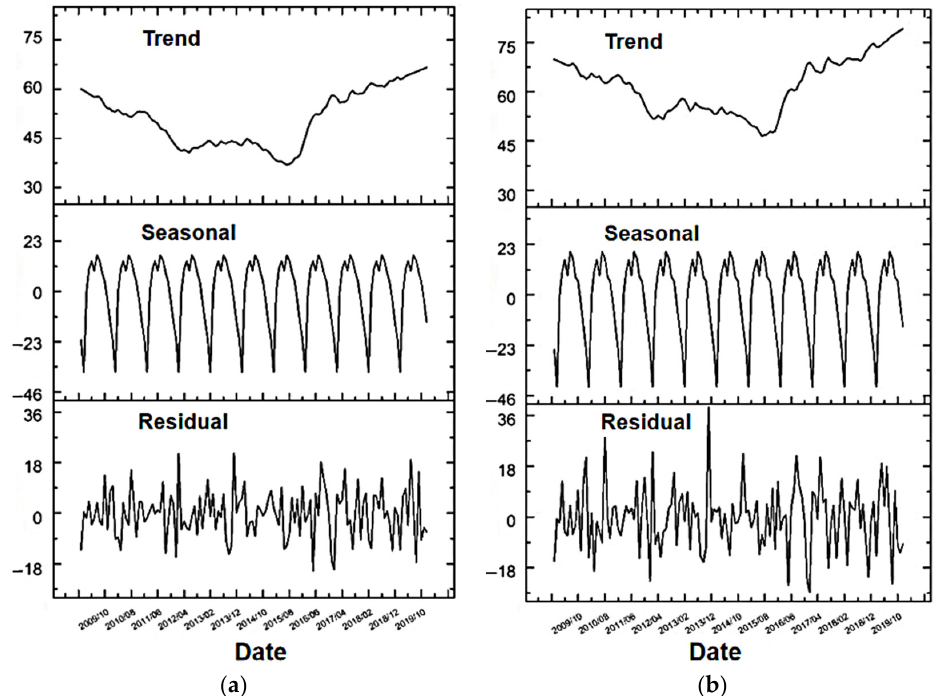
Figure 2. Breakdown chart of the monthly trend in the number of accidents and deaths: ( a ) the number of accidents; and ( b ) the number of deaths.